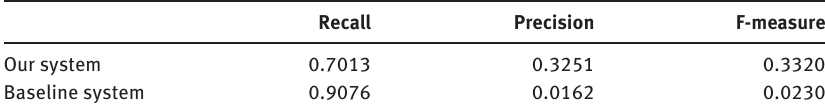
Table 5. Comparison of Our Method with A Previous System.